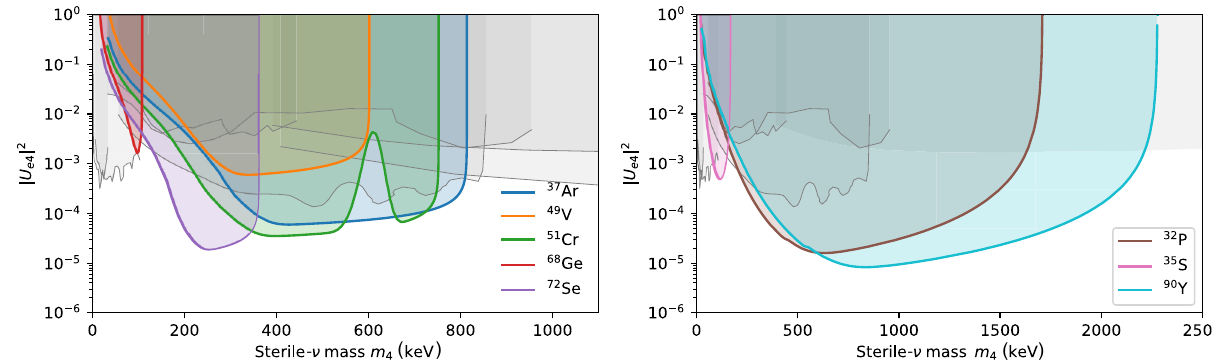
FIG. 4. The projected sensitivity to the mixing of a heavy-mass state, | U e 4 | 2 , as a function of the mass, m 4 , for a variety of isotopes, assuming that a single 100-nm-diameter nanosphere is measured for 1 month with 1% loading by the mass of the isotope of interest, and assuming the detection efficiencies and experimental parameters described in the text. The sensitivity for isotopes decaying by EC (left) and β − decays (right) are shown separately. The projected sensitivity is compared to the most sensitive existing laboratory limits in this mass range (gray) [7–15,17]. If sterile neutrinos constitute a significant fraction of dark matter, limits on x-ray emission from their radiative decays may also provide constraints in this mass range (not shown) [4].